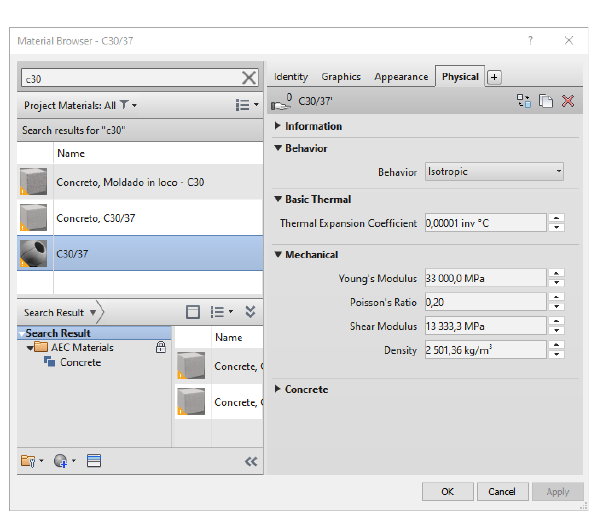
Figure 7. C30/37 concrete properties.